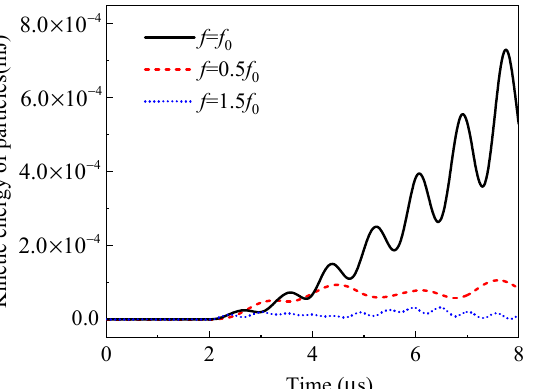
Figure 7. Time evolution of the total kinetic energies of the particles subject to the stress waves of different frequencies.